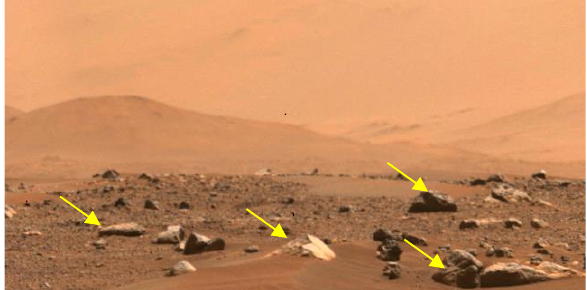
Figure 14 . Full range PC2 vs. PC3 (Region-3)